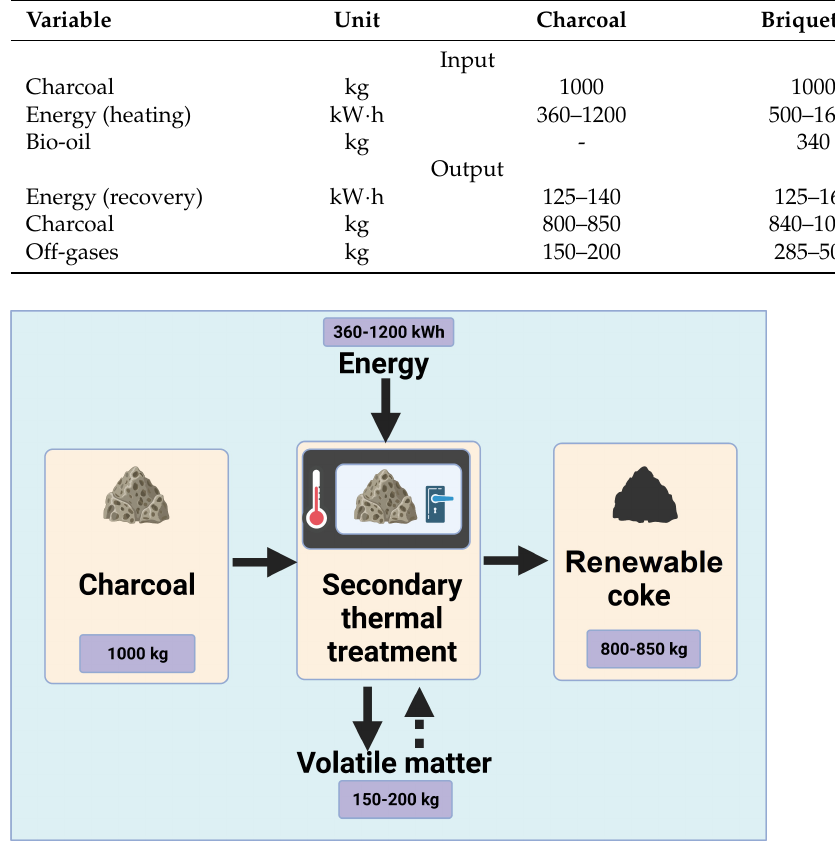
Figure 4. Flowsheet of the secondary heat